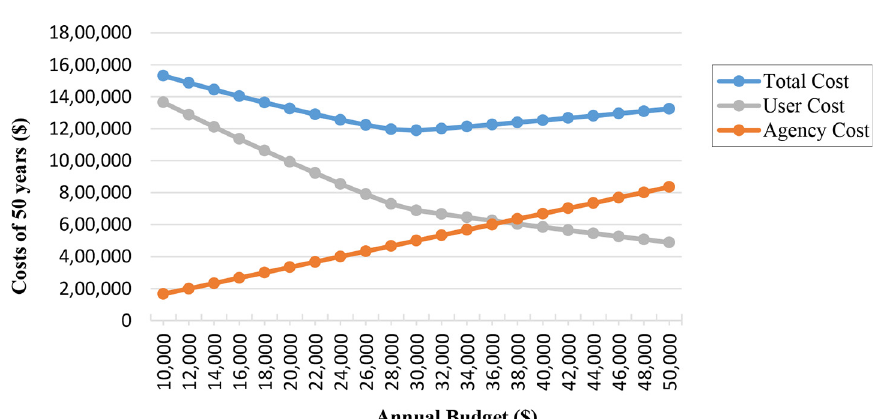
Figure 6. Total cost curves over the 50 decision cycles by solving DSDP model with different correlation coef fi cients